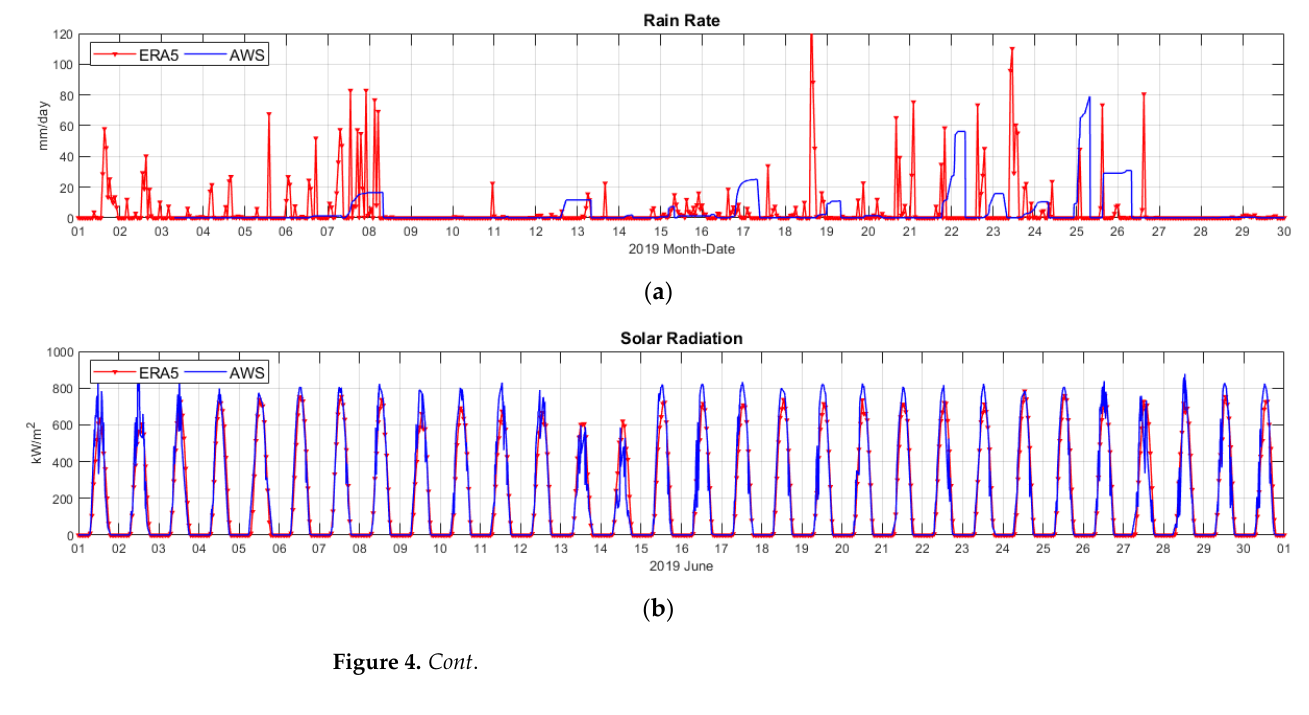
Figure 3. Location of Automatic Weather Station (AWS) in Ngurah Rai, Bali, and location of point for ERA5 data, in Bali Island, Indonesia.